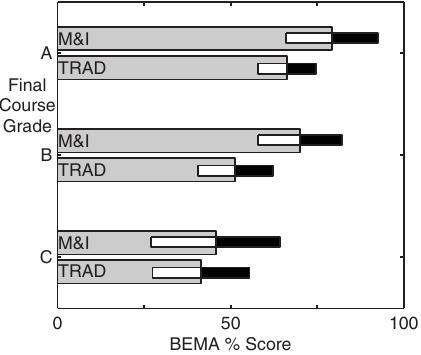
FIG. 10. The average BEMA score for students receiving a par- ticular final grade in introductory E&M at CMU is shown. In all cases, the BEMA test was administered 11 weeks after the comple- tion of the course. The error bounds indicate 95% confidence inter- vals on the estimates of the average for each grade. The numbers of students for which grades were obtained are N =14 for traditional students and N =32 for M&I students.